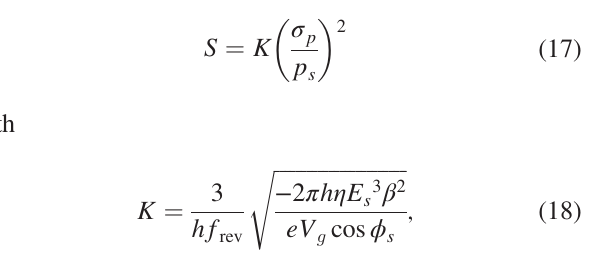
The voltage across the gap of a cavity is